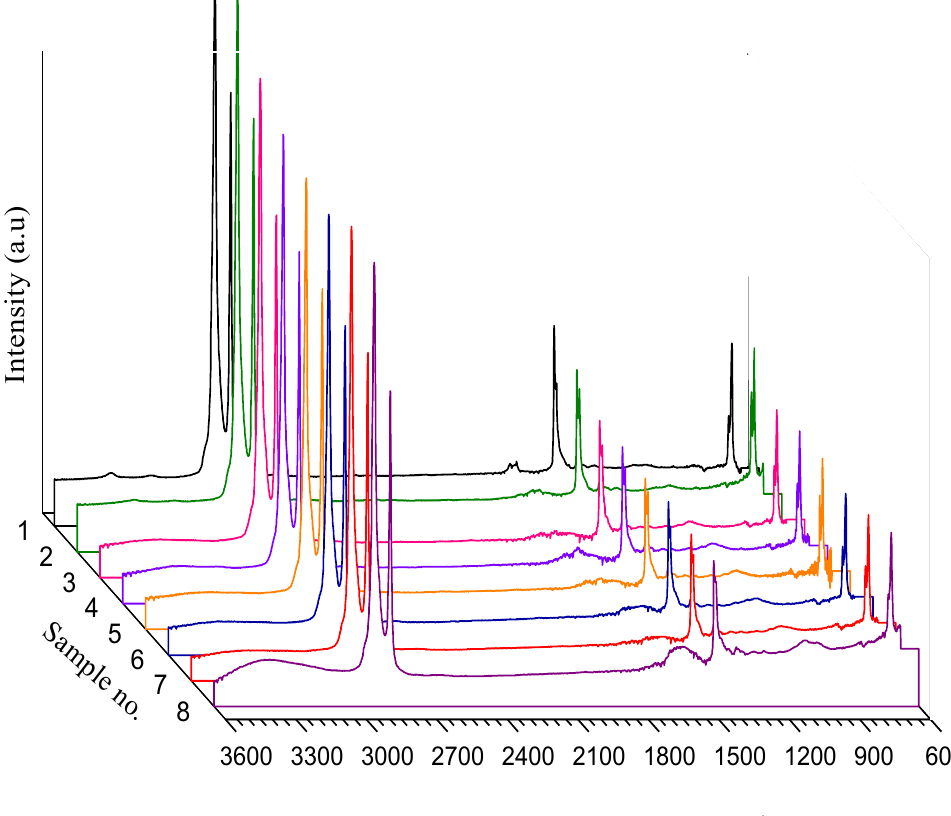
Figure 2. Attenuated total reflectance Fourier transform infrared (ATR-FTIR) spectra of samples 1–8 within the entire range of